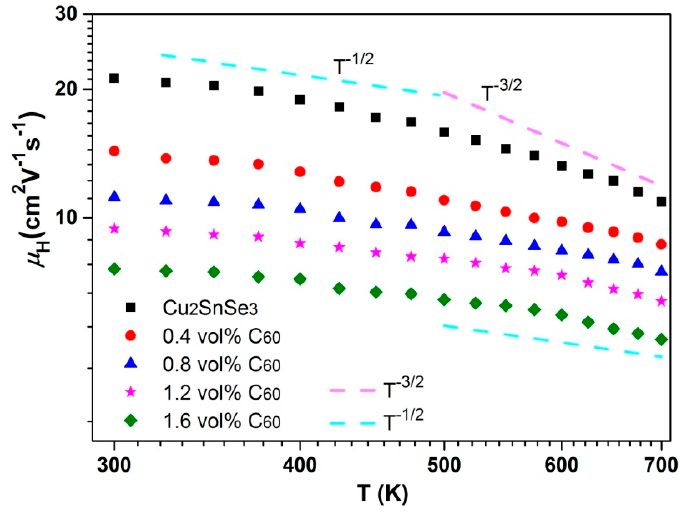
Figure 9. Temperature dependence of carrier mobility ( μ H ) of C 60 /Cu 2 SnSe 3 composites.